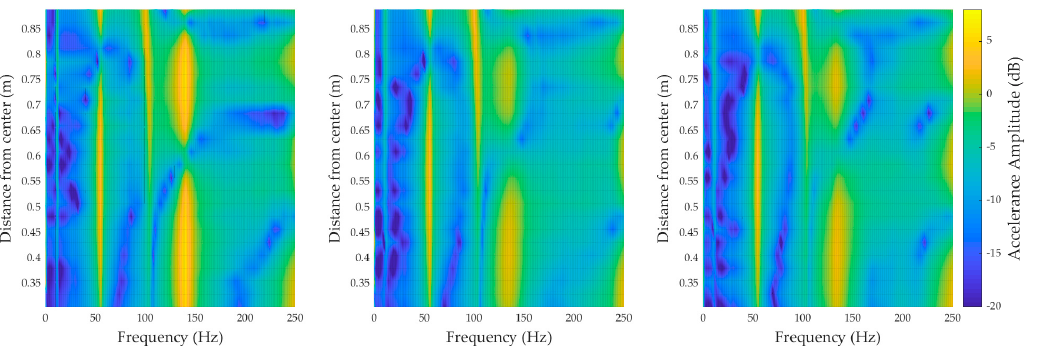
Figure 5. Accelerance maps of a Völkl Racetiger: ( left ) without; ( center ) deactivated; ( right ) UVO activated.